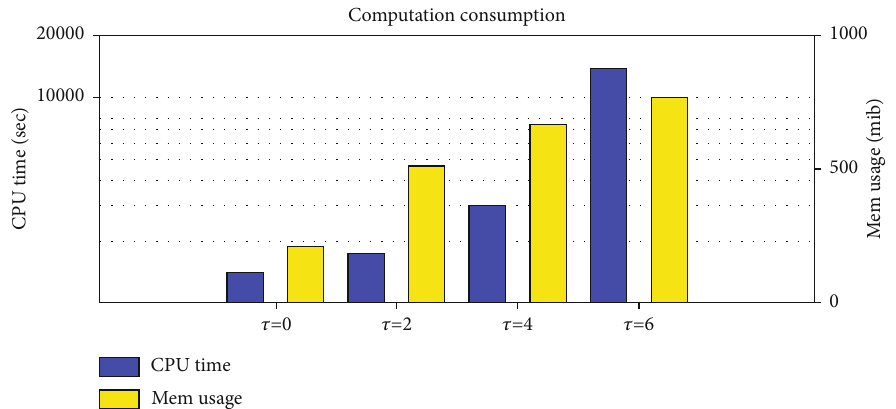
Figure 6: Computation cost of 100 simulation runs. The CPU time (blue) is presented in the logarithmic scale, and memory usage (yellow) is displayed in the linear